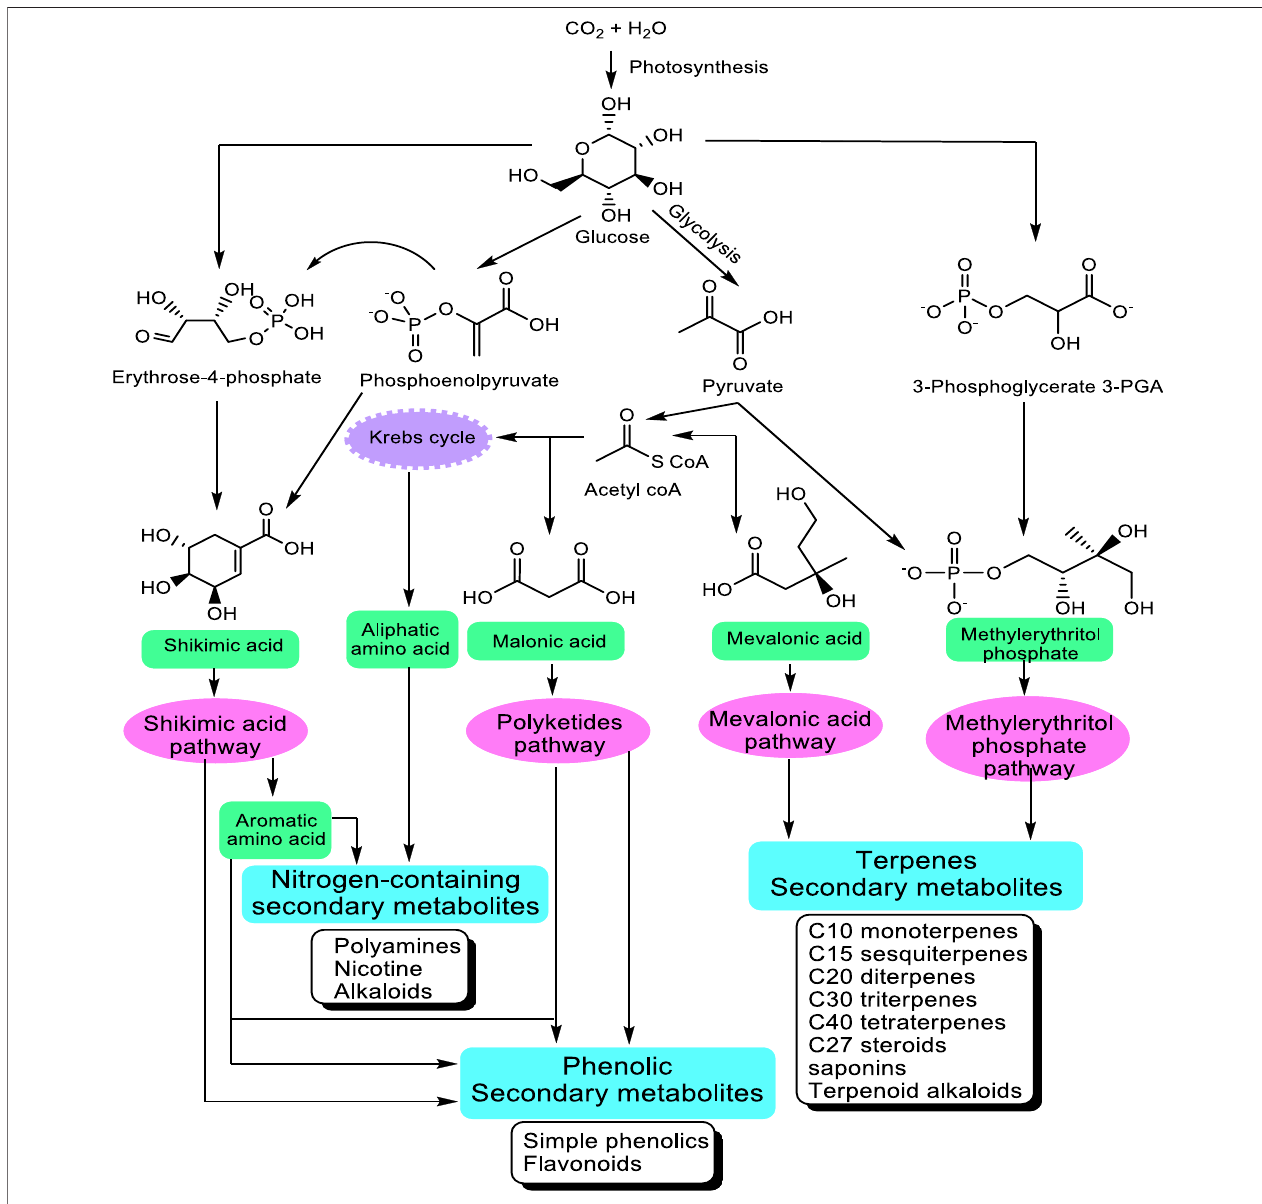
FIGURE 1 | Main pathways leading to SM modi fi ed from Wink (2010). The non-mevalonate pathway or 2-C-methyl-D-erythritol 4-phosphate/1-deoxy-D-xylulose 5-phosphate pathway (MEP/DXP pathway) of isoprenoid biosynthesis is an alternative metabolic pathway leading to the formation of isopentenyl pyrophosphate (IPP) and dimethylallyl pyrophosphate (DMAPP) and fi nally